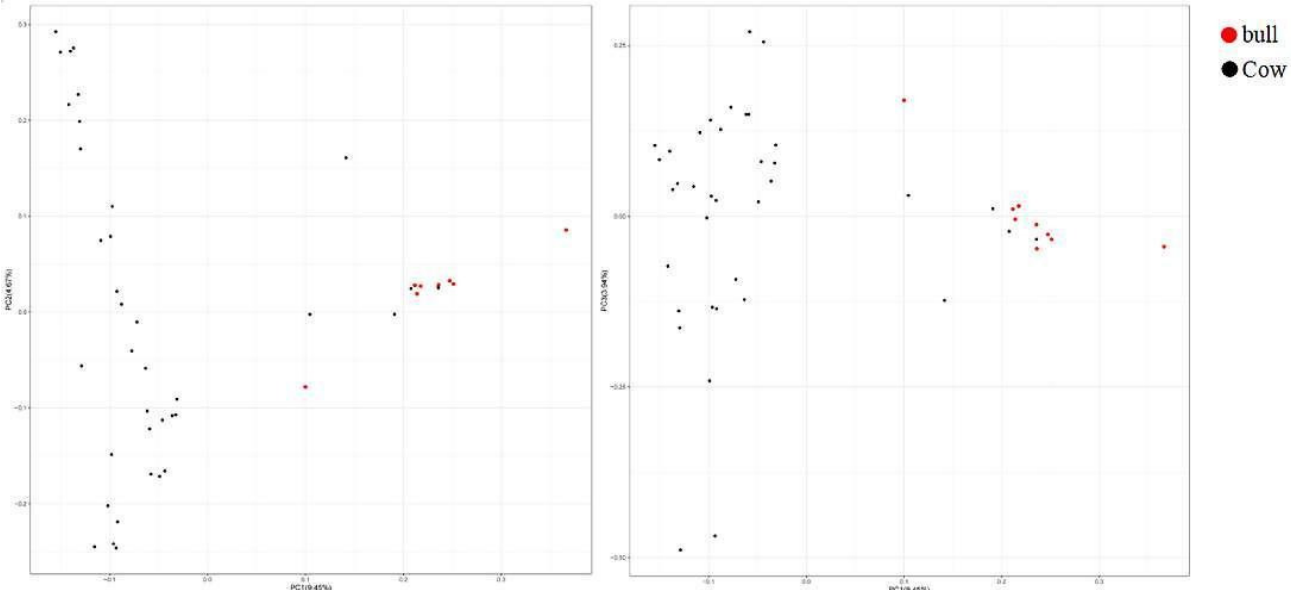
Figure 6. Principal component analysis results.